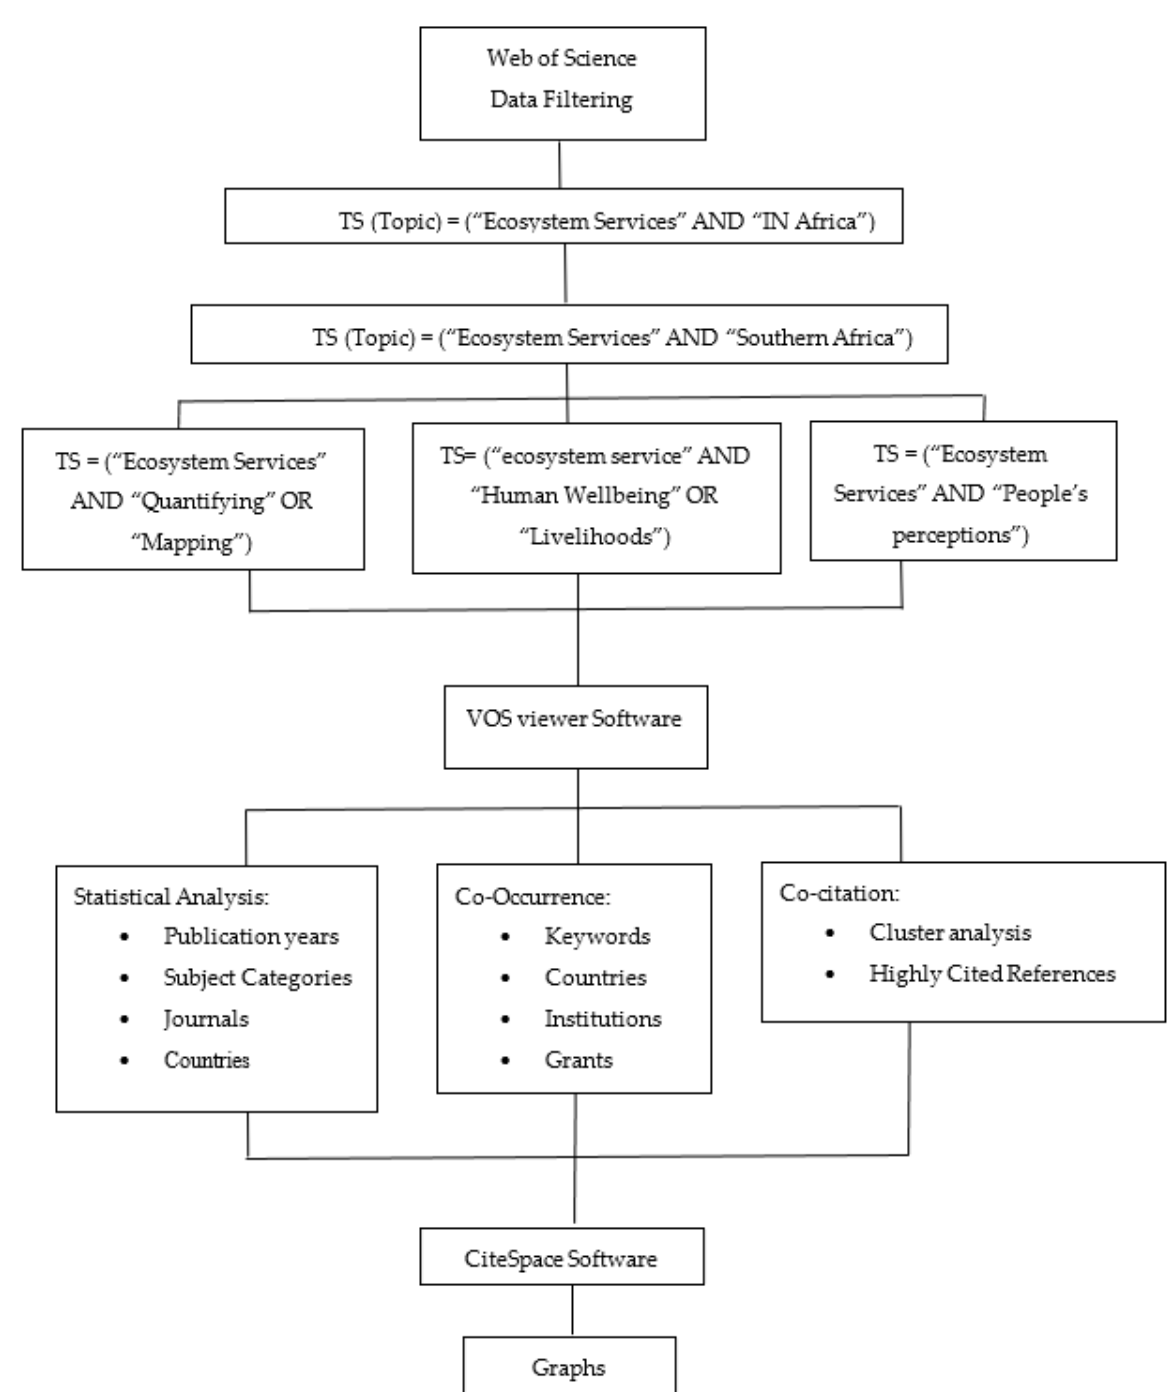
Figure 1. Schematic of bibliometric analysis employed for this study.